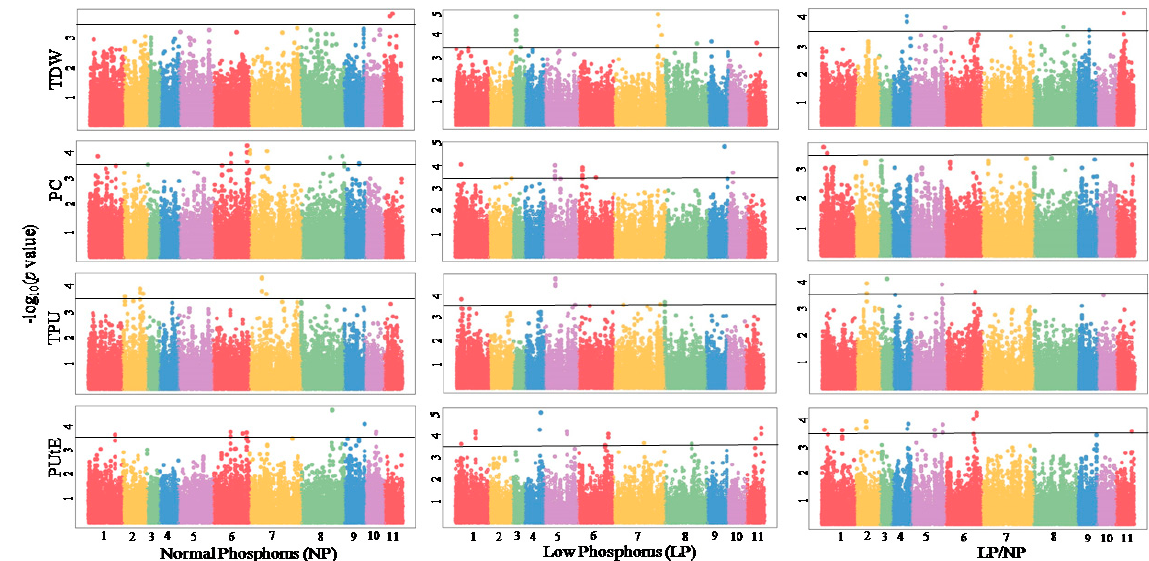
Figure 6. MLM based Manhattan plots depicting the significant association of SNP markers with total dry weight (TDW), P concentration (PC), total P uptake (TPU) and P utilization efficiency (PUtE) under NP, LP and LP/NP conditions.